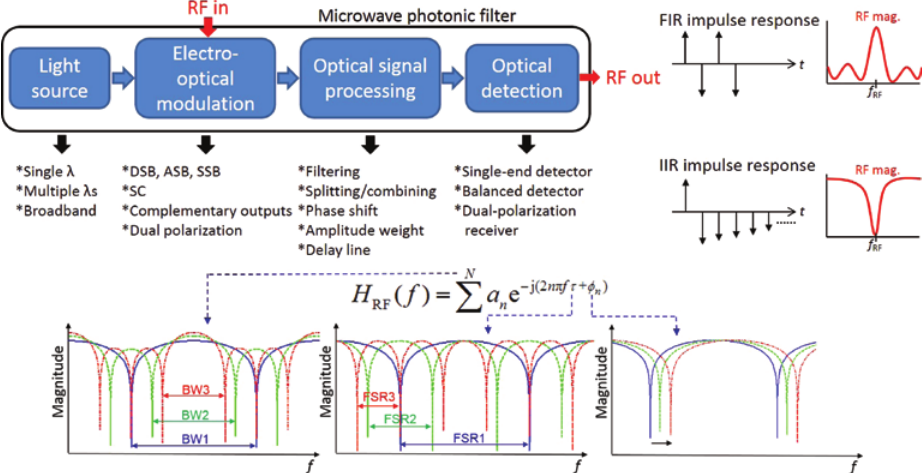
Figure 1: General system architecture of MWP